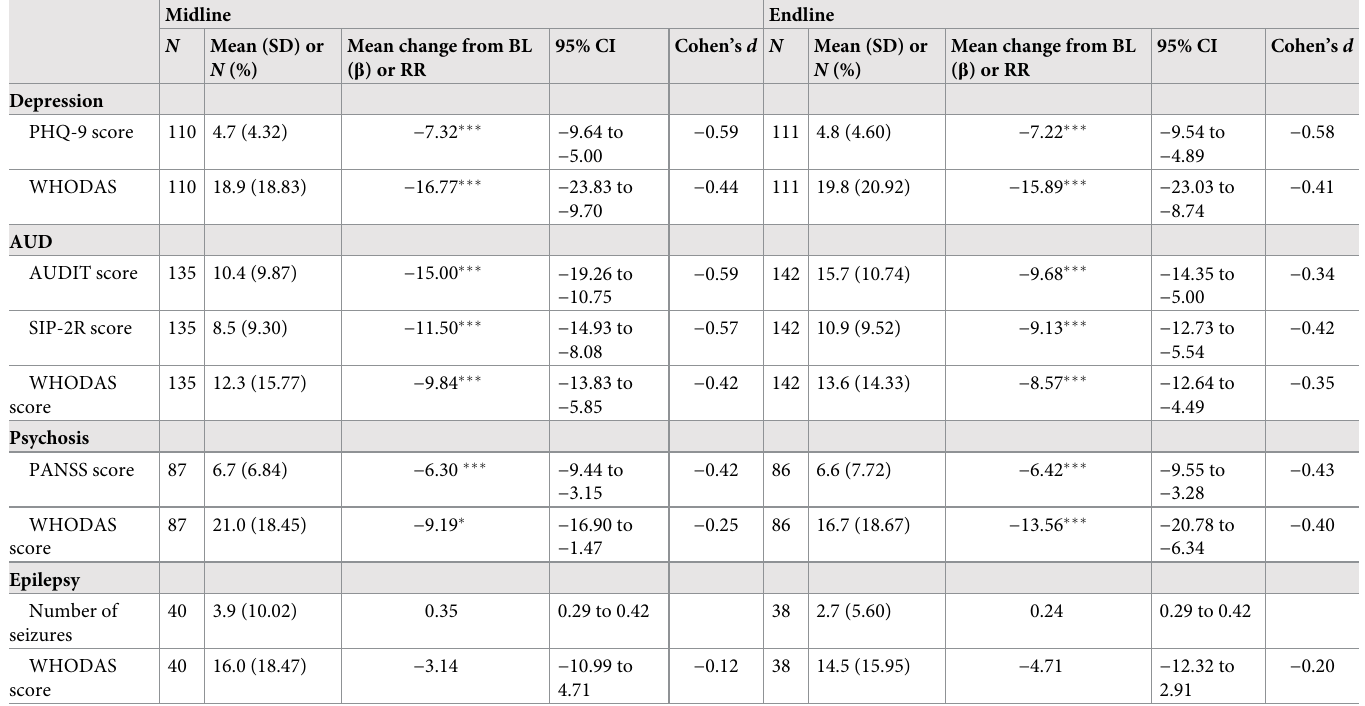
Table 7. Impact of PRIME mental healthcare plan on individual-level